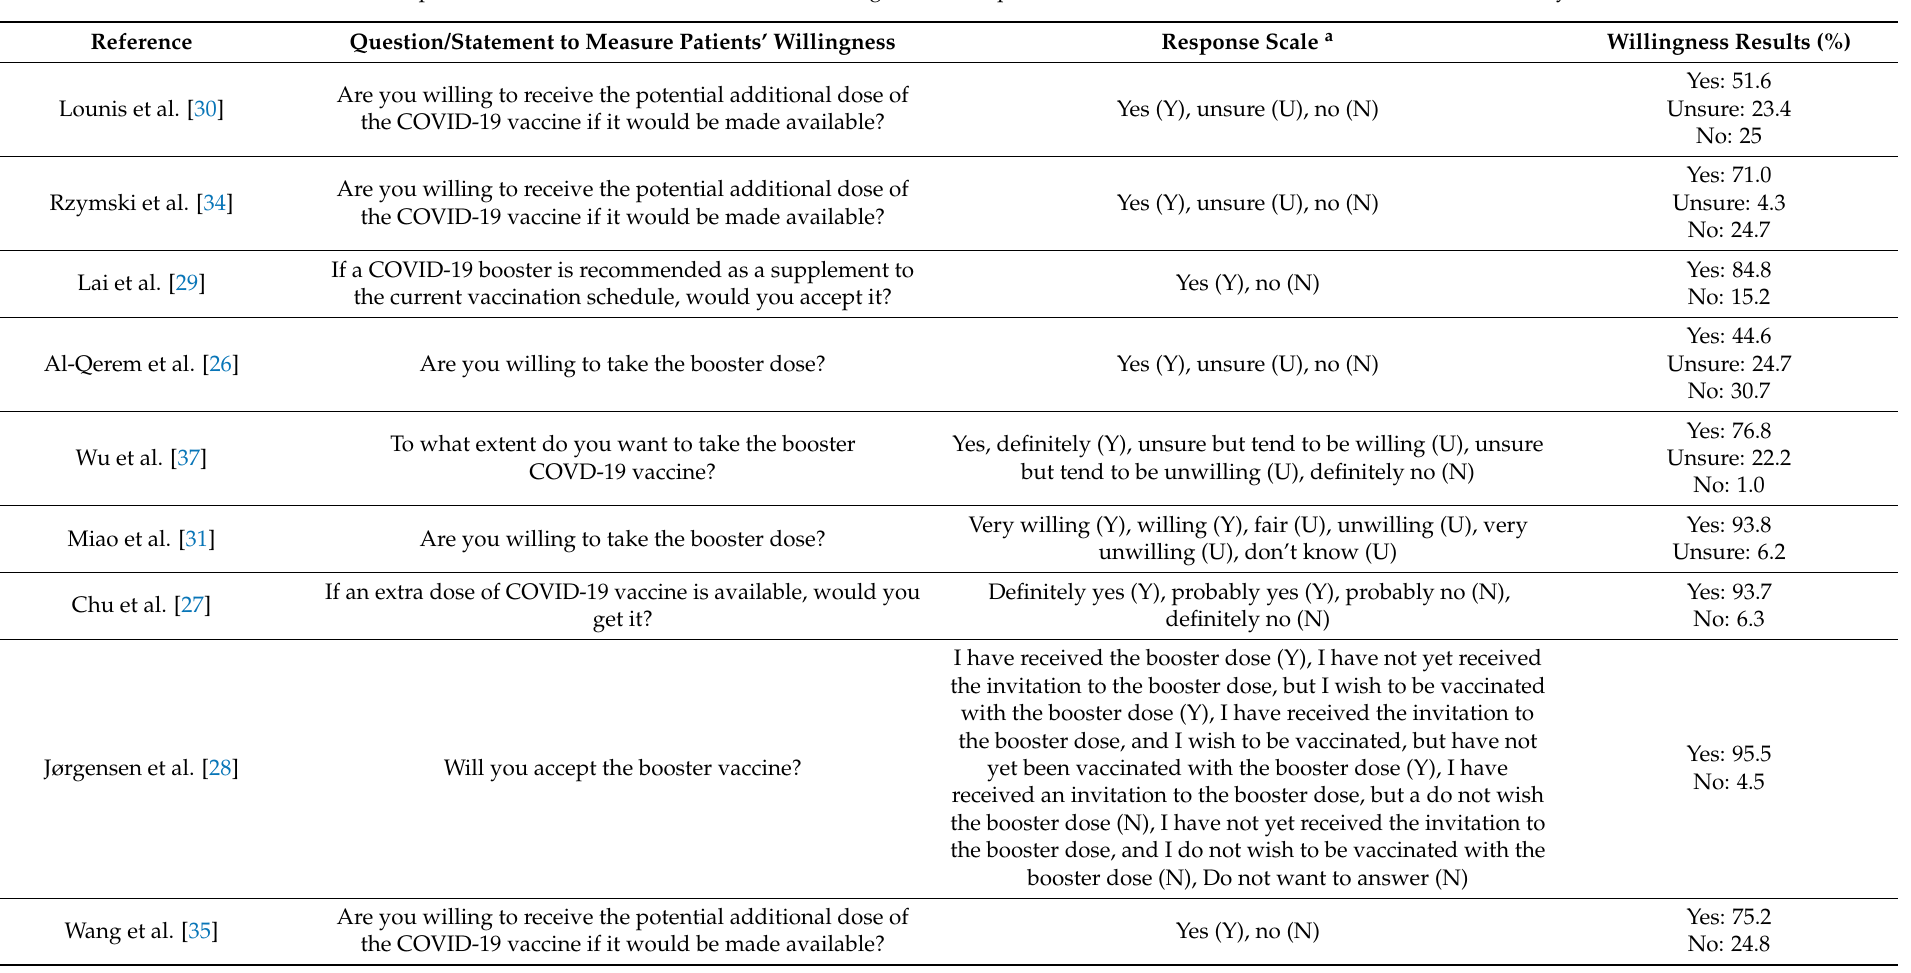
Table 2. Response scales and results of individuals’ willingness to accept a first COVID-19 booster dose in studies included in systematic